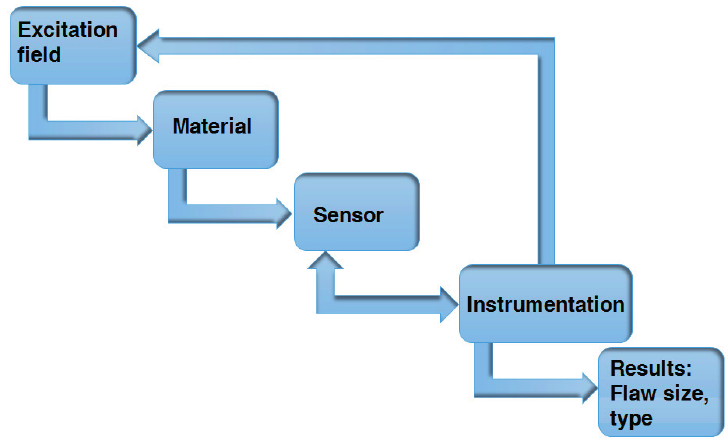
Figure 1. Principles of nondestructive evaluation